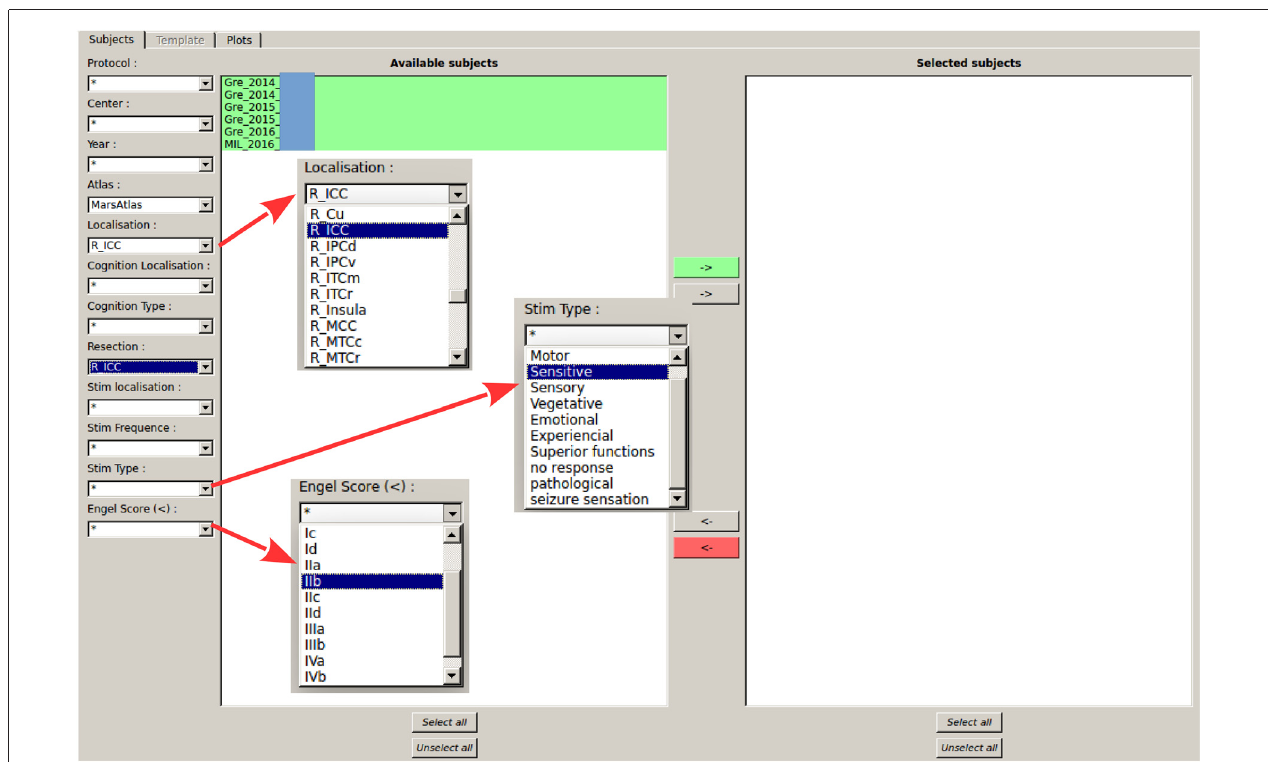
FIGURE 9 | Selection of patients according to labels. All patients from the database validating all criteria selected on the left are shown in the available subject list. Matching criteria on the left-hand side of the GUI are: center and year of acquisition, contact localization according to the parcels (here MarsAtlas parcels, but other atlases can be chosen), cognitive response from SEEG data (still under development), resected parcels, stimulated parcels, stimulation parameters, Engel’s score. In the shown configuration, the software indicates all patients who had an electrode contact in the right isthmus of the cingulate cortex (R_ICC) and for whom the resective surgery included at least partially the right ICC.